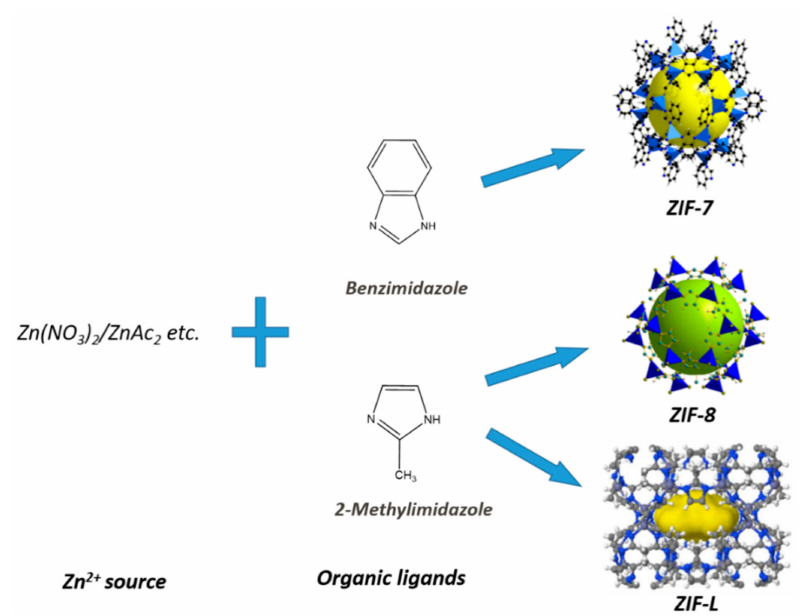
Figure 2. Structure and preparation route of ZIF-7, ZIF-8 and ZIF-L